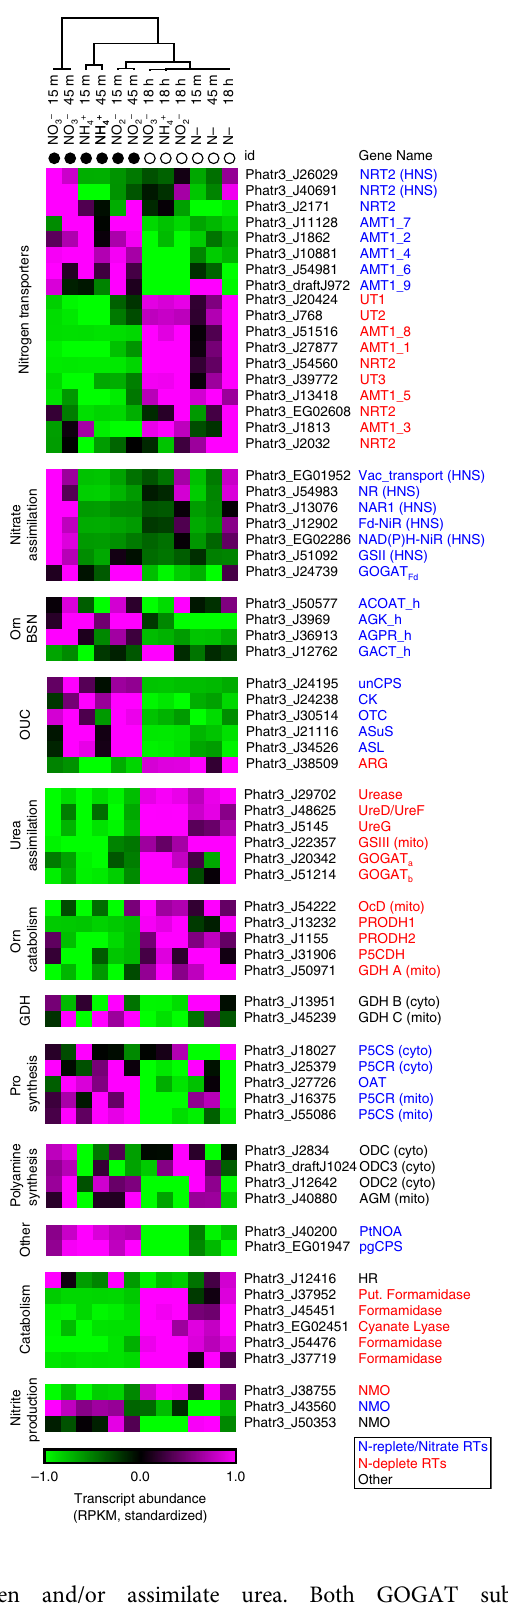
Fig. 5 Transcript-level expression of nitrogen assimilation genes and intersecting pathways. Heatmap shows standardized transcript abundance (RPKM) for nitrogen catalog genes, identi fi ed with protein ID and gene names, and organized by known or hypothesized pathways. Gene name abbreviations can be found in Supplementary Data 3. Dendrogram shows hierarchical clustering (one-minus Pearson correlation, average linkage) of nitrogen transporter genes only, with the other genes in the same arrangement. Closed circles indicate N-replete time points, open circles show N-deplete time points. Color of gene name indicates whether it was in a nitrate-speci fi c or N-replete response type (blue), an N-deplete response type (red), or other (black). Source data are provided as a Source Data fi le